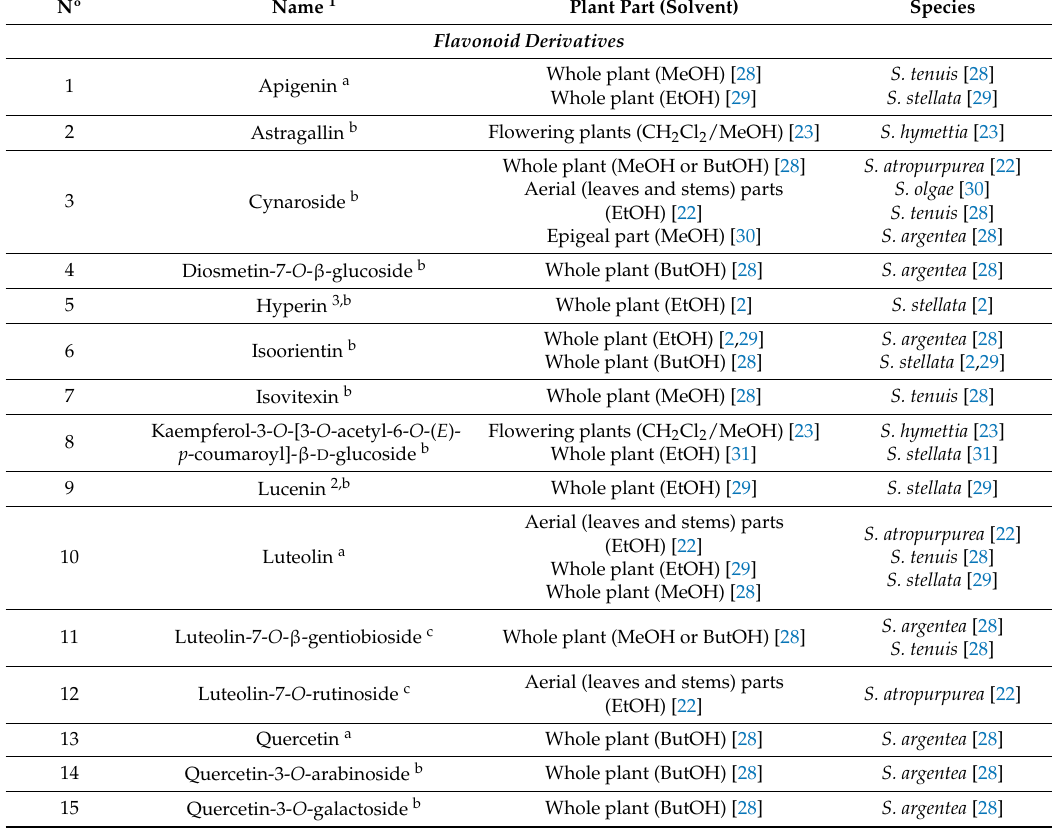
Table 1. Secondary metabolites isolated from Scabiosa